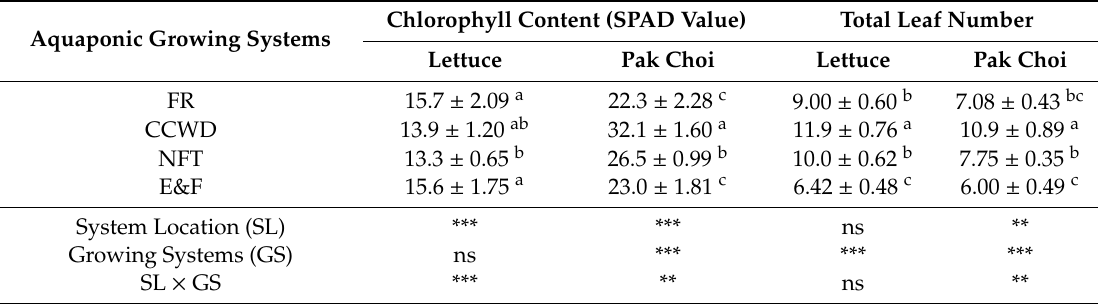
Table 3. Leaf chlorophyll content and the total leaf number of lettuce and pak choi cultivated under di ff erent aquaponic growing systems.